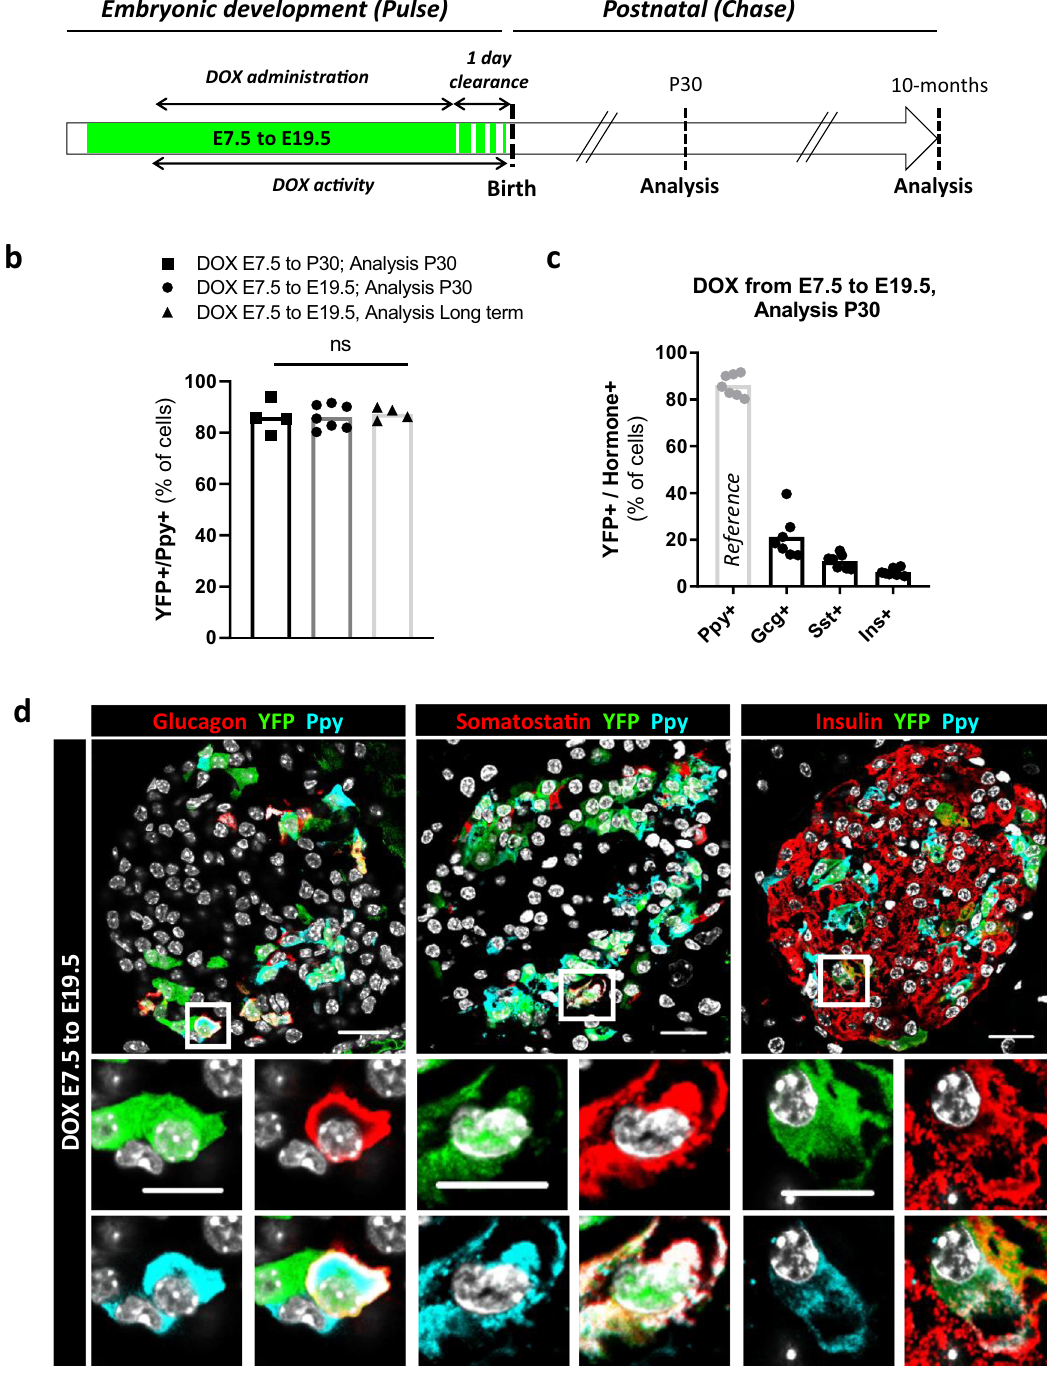
Fig. 2 Adult γ -cells derive from embryonic Ppy-expressing cells. a Embryonic Ppy-expressing cell labeling strategy. DOX doxycycline, P30 postnatal day 30. b The proportion of adult YFP-labeled Ppy-expressing cells is maintained in the different DOX administration periods. DOX E7.5 to P30, analysis P30 (black; n = 4 mice, 1842 Ppy + YFP + out of 2131 Ppy + cells scored); DOX E7.5 to E19.5, analysis P30 (dark gray, n = 7 mice, 3111 Ppy + YFP + out of 3604 Ppy + cells scored); DOX E7.5 to E19.5, analysis 9-month-old (light gray, n = 4 mice, 2241 Ppy + YFP + out of 2565 Ppy + cells scored). Data are shown as mean ± s.e.m; two-tailed Mann – Whitney test. P values: DOX E7.5 to P30, analysis P30 vs DOX E7.5 to E19.5, analysis P30 = 0.9273; DOX E7.5 to P30, analysis P30 vs DOX E7.5 to E19.5, analysis long term = 0.6857. c Percentage of adult hormone + cells (Gcg + , Sst + or Ins + ) labeled with YFP when DOX was given during embryogenesis. 21.1 ± 0.0%, 10.8 ± 0.0% and 6.1 ± 0.0% of Gcg + , Sst + and Ins + , respectively, were YFP-traced. The percentage of YFP- labeled Ppy + cells is taken for reference from panel b . Data are shown as mean ± s.e.m; n = 7 mice; 810 YFP + Gcg + out of 4196 Gcg + , 285 YFP + Sst + out of 2669 Sst + and 1306 YFP + Ins + out of 20753 Ins + cells scored. d Immuno fl uorescence of YFP (green)-traced cells co-expressing Glucagon (red, left panel), Somatostatin (red, middle panel) and Insulin (red, right panel) with Ppy (cyan) at P30. Scale bar: 20 μ m (10 μ m in insets). Region of the pancreas: Ventral. Source data are provided as Source Data fi le (Supplementary Table